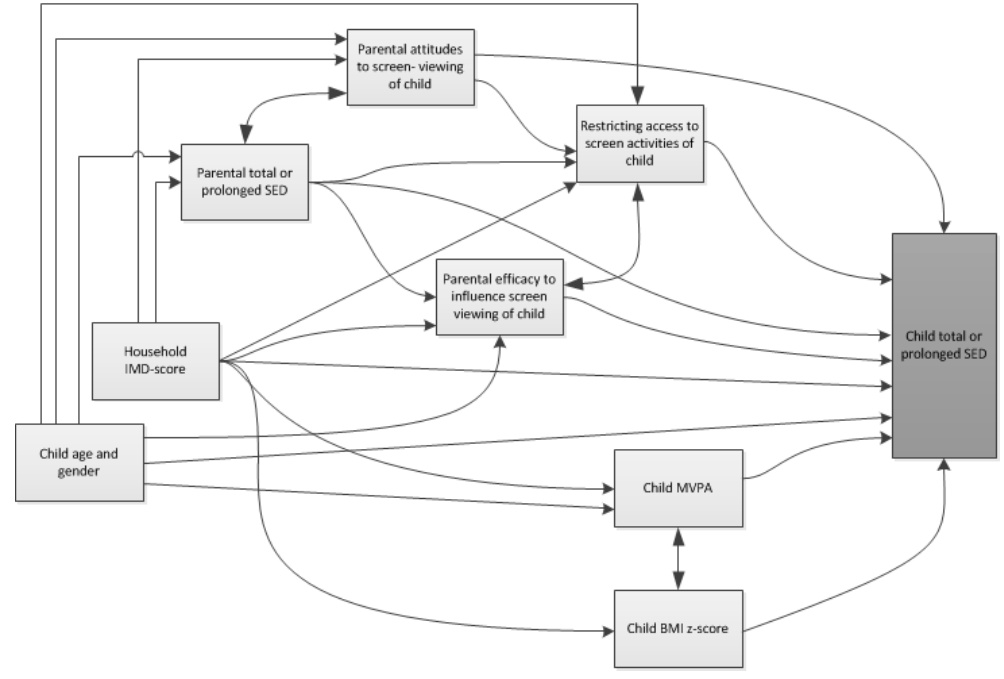
Figure 1. Potential correlates of children’s total and prolonged sedentary time (SED) and their expected associations. IMD, index of multiple derivation; MVPA, moderate-to-vigorous-intensity physical activity; BMI, body mass index.